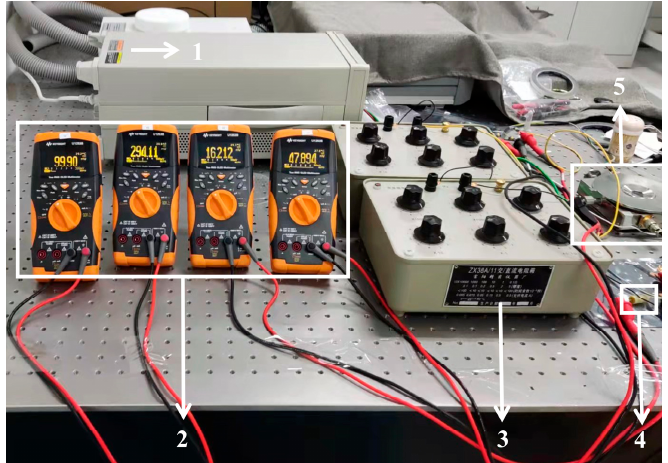
Figure 4. The electrical circuit used for resistance measurement of Pt film.